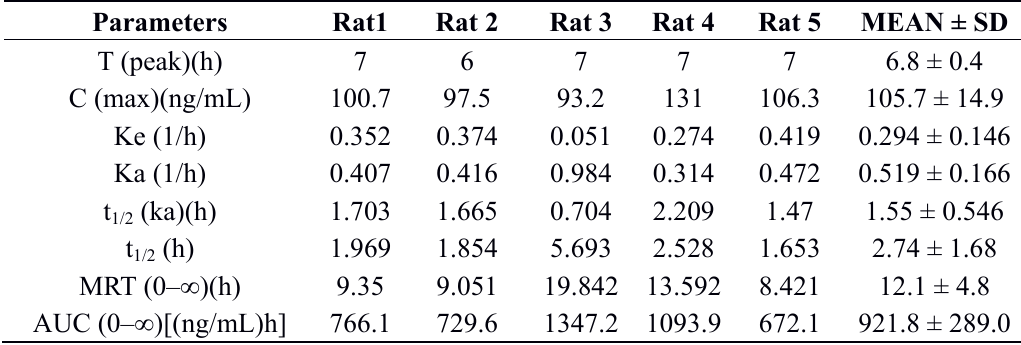
Table 16. Pharmacokinetic parameters of TA-III after intragastrical administration to rats at a dose of 25